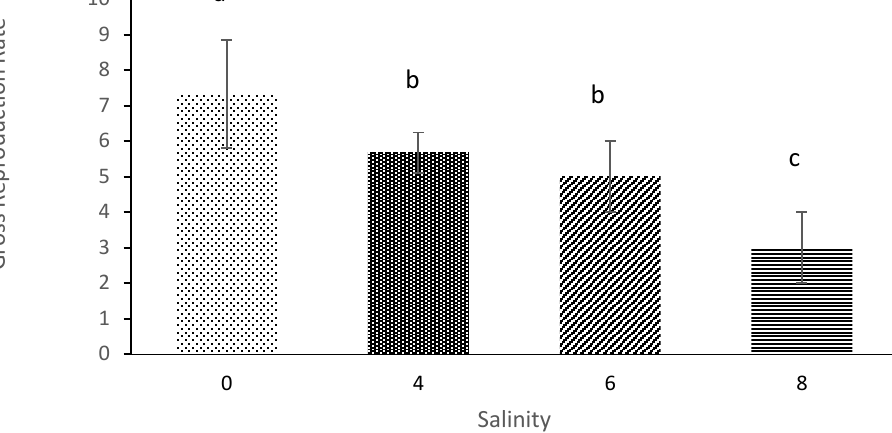
Figure 8. The gross reproduction rate of M. macrocopa for different salinity treatments. The different small letters indicate significant differences between different salinity treatments ( p < 0.05).